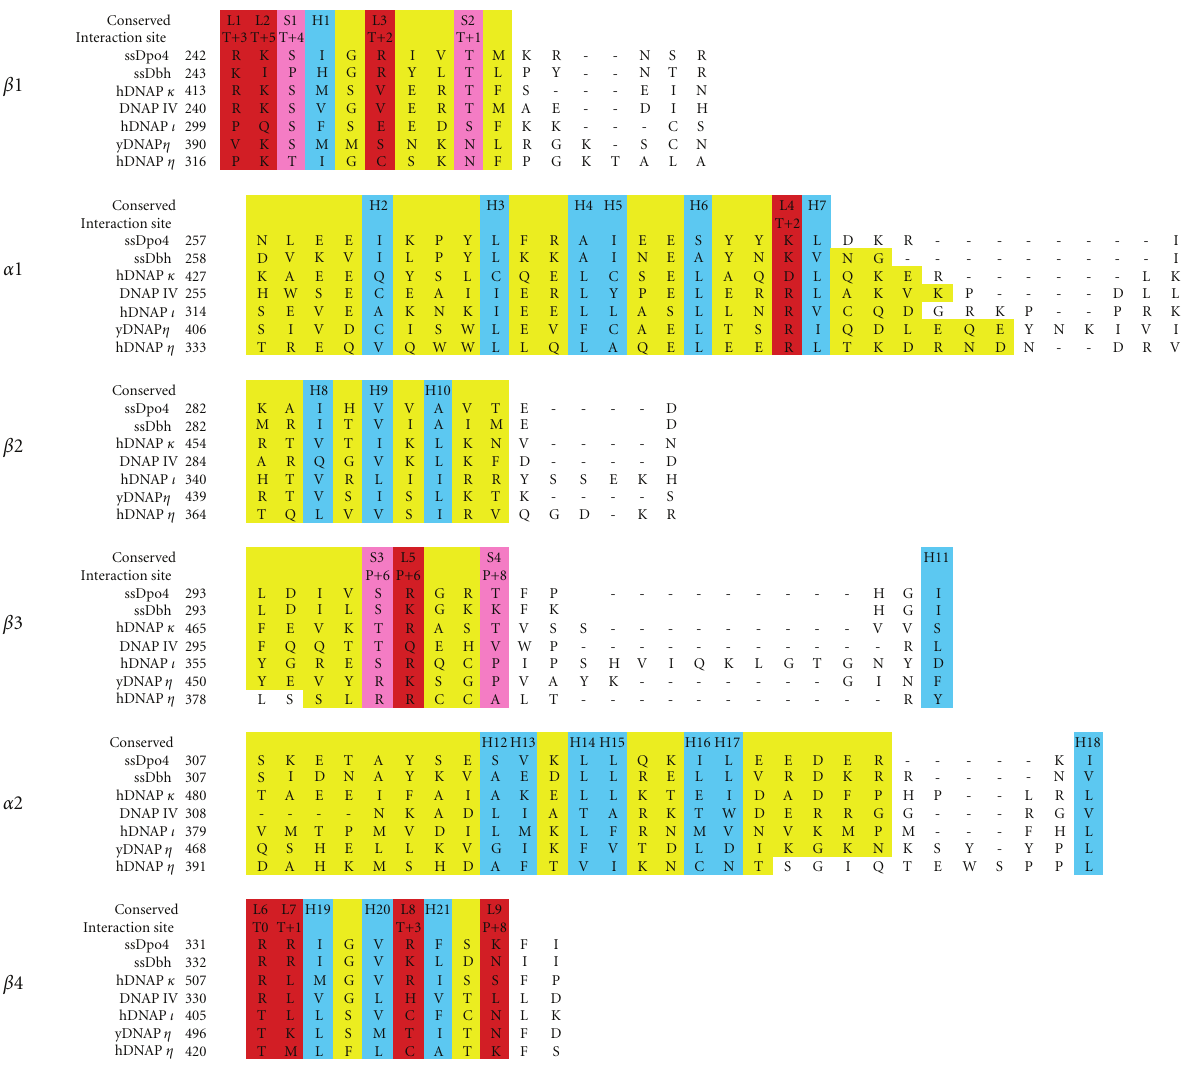
Figure 4: Amino acid alignment for the little finger domains in cases where the alignment can be assigned unambiguously based on X-ray structures of Y-family DNAPs. Alignments were done with FATCAT [105] and MAMMOTH [106], which agreed with visual alignment. The six rows show the four β -strands ( β 1– β 4) and the two α -helices ( α 1 and α 2). Yellow highlighting indicates residues in each secondary structural block. Blue highlighting shows the twenty-one hydrophobic residues (H1–H21) that make up the hydrophobic core of the little finger domains. Red highlighting shows consensus lysine/arginine/asparagine/glutamine residues that bind with phosphate-oxygens (L1– L9). Pink highlighting shows consensus serine/threonine residues that bind with phosphate-oxygens (S1–S4). “Interaction Site” refers to the nucleotide position of the phosphate-oxygen with which an amino acid is interacting, where “T” refers to template and “P” refers to primer, and the numbering refers to the duplex portion of the DNA. The interaction site is not always the same in all structures in the case of amino acids with long side